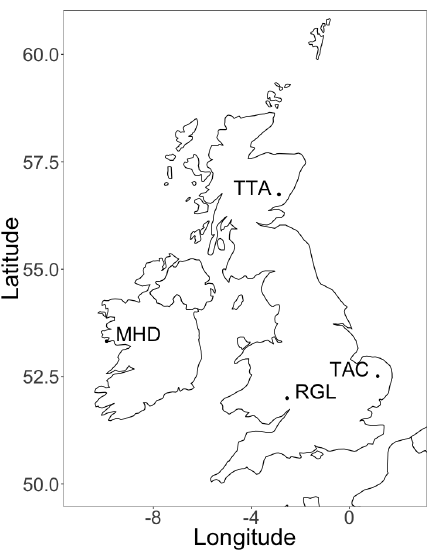
Figure 2. The case studies use the four UK DECC network mea- surement stations located on this map. RGL is Ridge Hill, TAC is Tacolneston, TTA is Angus and MHD is Mace Head